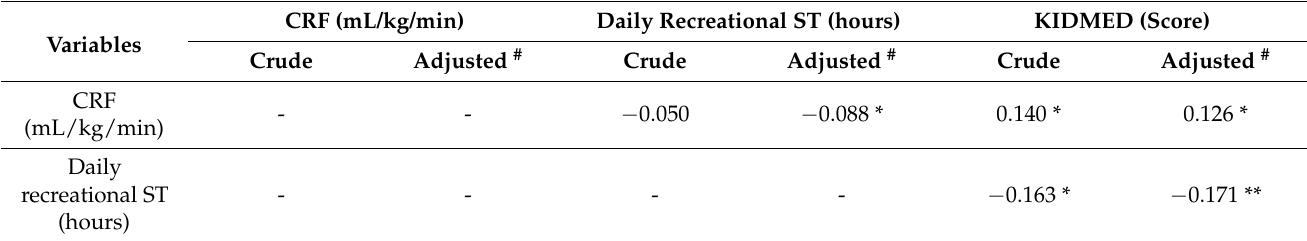
Table 2. Bivariate and partial correlations among cardiorespiratory fitness, recreational screen time, and adherence to the Mediterranean